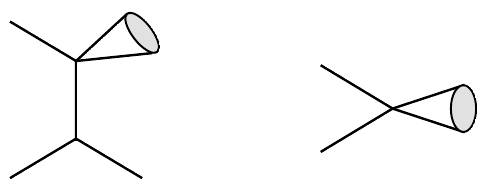
Figure 3 . Prototype Feynman diagrams for DS production: associated production SM + SM → DS + SM (left), and single production SM + SM → DS (right). Solid lines denote SM particles, the gray blob stands for a DS